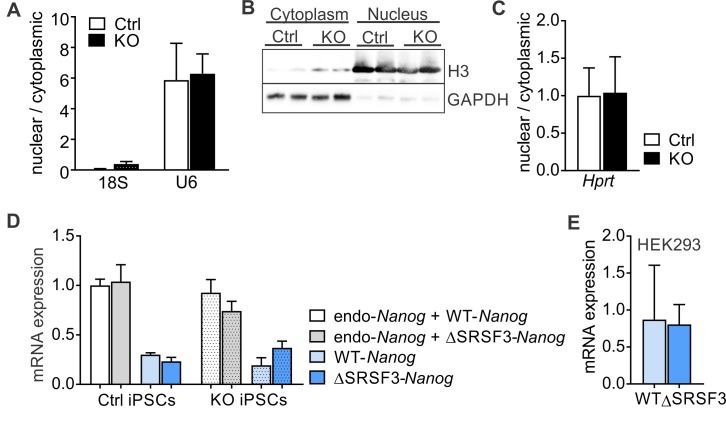
SRSF3 binding is essential for Nanog mRNA export.(A) Srsf3-KO and control iPSCs were fractionated into nuclear and cytoplasmic fractions 24 hr after 4OHT induction. RT-qPCR quantification of cytoplasmic 18S ribosomal RNA and nuclear U6 snRNA levels in the nuclear and cytoplasmic fractions. Data is presented as nuclear to cytoplasmic ratio (data as mean ± SEM, n = 2). (B) Western blot analysis of the nuclear histone H3 and cytoplasmic GAPDH in the subcellular fractions of control and Srsf3-KO iPSCs. (C) RT-qPCR quantification of Hprt mRNA in the nuclear and cytoplasmic fractions Srsf3-KO and control iPSCs, showing no change in Hprt distribution following SRSF3 depletion. Data is presented as nuclear to cytoplasmic ratio (data as mean ± SEM, n = 5). (D) RT-qPCR quantification ofa endogenous Nanog mRNA expression and the ectopically expressed WT-Nanog and ΔSRSF3-Nanog mRNAs in control and SRSF3 depleted pluripotent cells (data as mean ± SEM, n = 3, ns). (E) RT-qPCR quantification of ectopically expressed WT-Nanog and ΔSRSF3-Nanog mRNAs in HEK293 cells (data as mean ± SEM, n = 2).